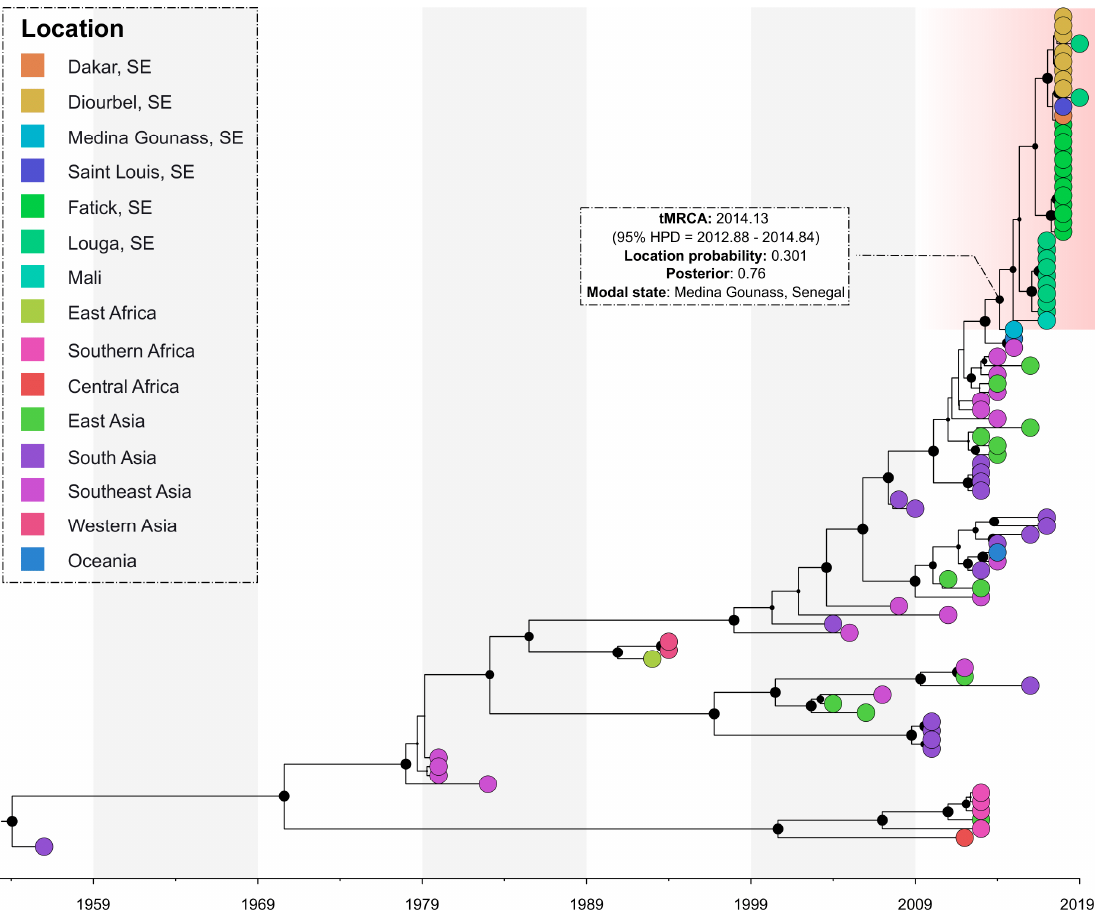
Figure 3. Bayesian discrete phylogeography of dengue strains isolated in Senegal between 2015–2019. Senegalese strains are grouped in a monophyletic cluster (highlighted in red). The black marbles in the nodes represent the posterior probability value and their size is proportional to their value.